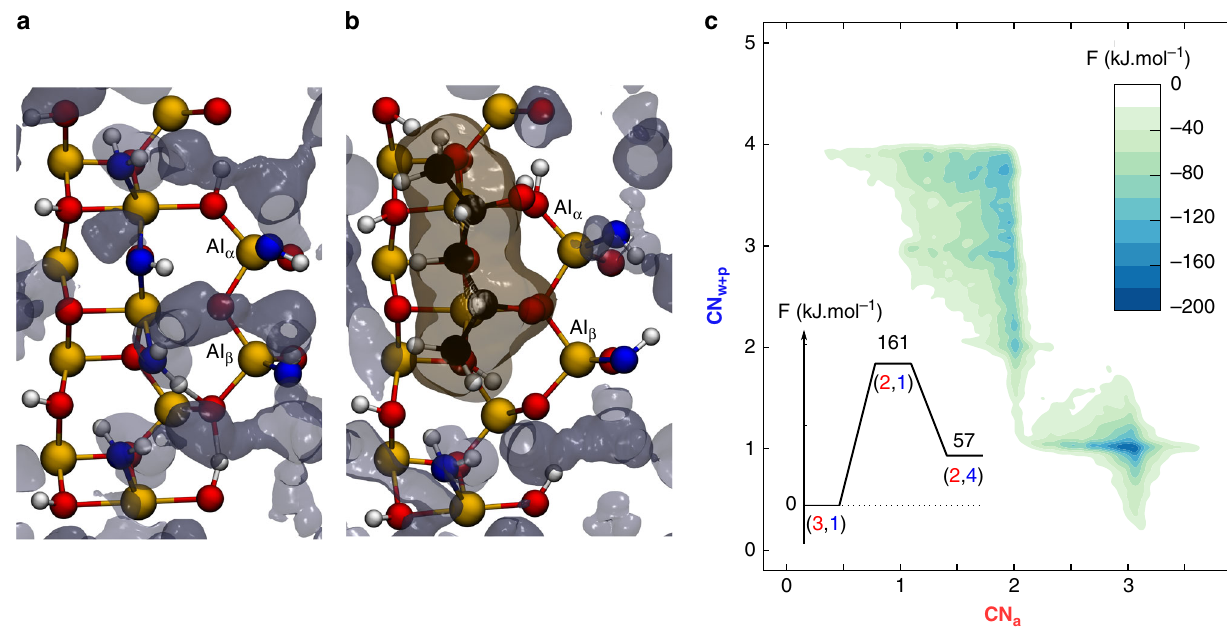
Fig. 3 Inhibition of the decomposition of γ -Al 2 O 3 in the presence of chemisorbed xylitol. a γ -Al 2 O 3 (110)/water interface with the average occupation volume of water in gray. b Geometry of adsorbed xylitol at the γ -Al 2 O 3 (110)/water interface with the iso-surface of the average occupation volume of xylitol in ochre, and the average occupation volume of water in gray. The iso-surfaces were computed from an extra regular ab initio molecular dynamics simulation. More details can be found in Supplementary Note 8. c Free energy surface obtained from the metadynamics simulation on Al β in presence of xylitol. CN a is the coordination number of Al β to alumina oxygen atoms. CN w + p is the coordination number of Al β to water and polyols oxygens. Yellow and white balls represent aluminum and hydrogen atoms, respectively. The color red is used for alumina oxygen atoms and the associated CN a . The color blue is used for water oxygen atoms and the associated CN